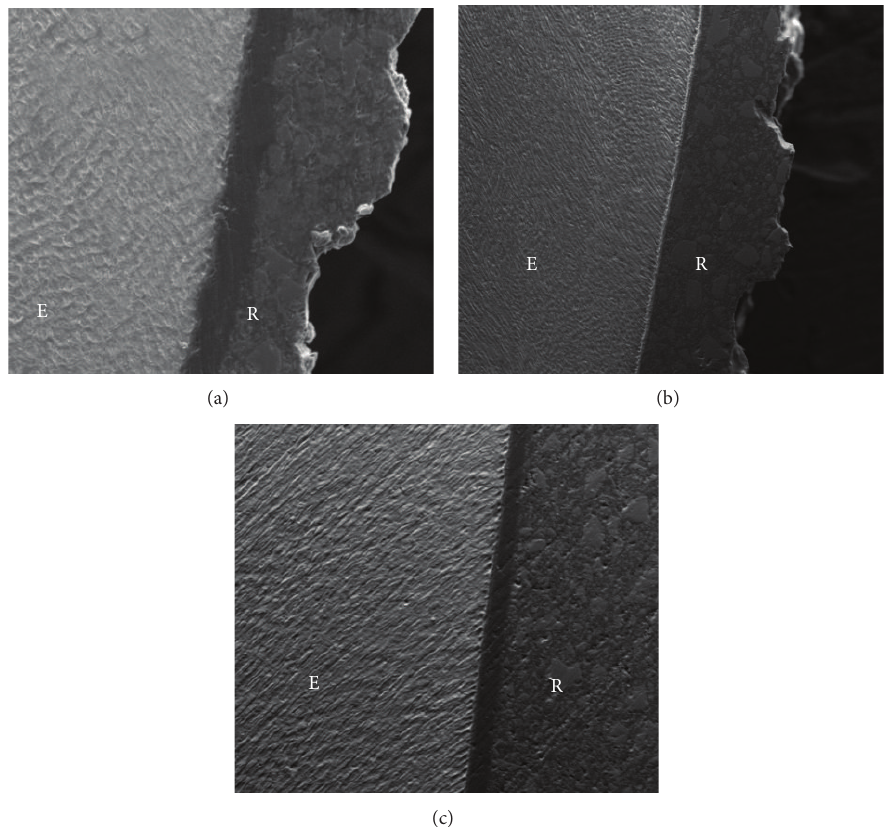
Figure 3: (a) Microimages of group XT. Magnification of 500x. (b) Microimages of group SEP. Magnification of 500x. (c) Microimages of group OL. Magnification of